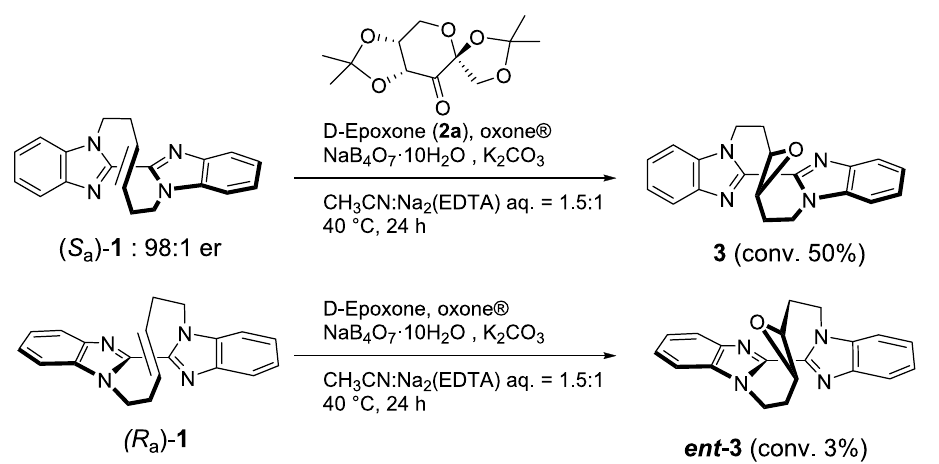
Figure 2. Scheme on rate difference of bisbenzoimidazole 1 of both enantiomers by Shi’s asymmetric